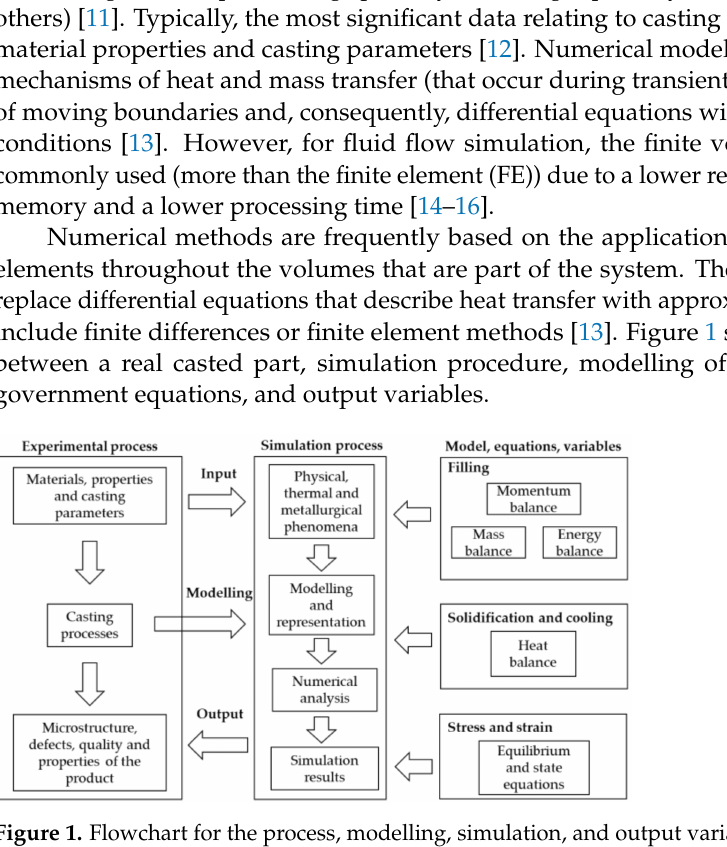
Figure 1. Flowchart for the process, modelling, simulation, and output variables (adapted from